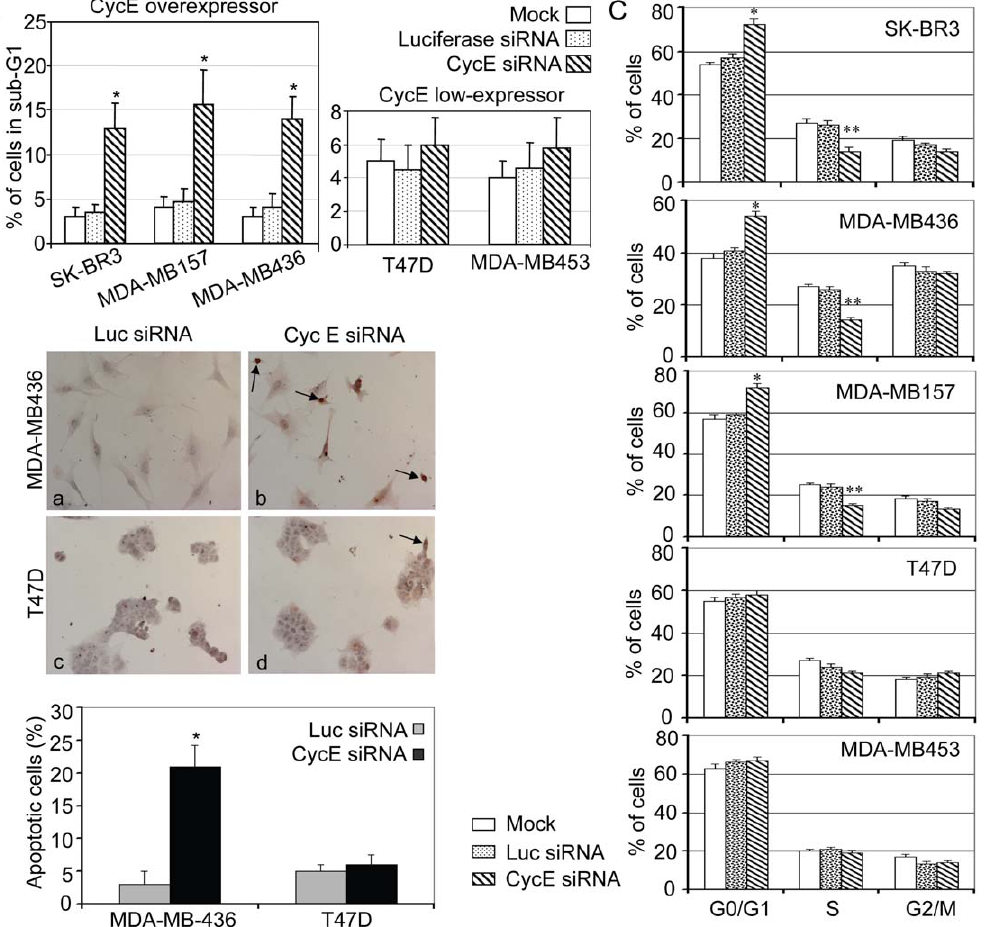
Figure 2. Apoptosis and decreased cell proliferation induced by depletion of cycE in cycE-overexpressing breast cancer cells. A) Downregulation of cycE promotes apoptosis of SK-BR3, MDA-MB436 and MDA-MB157, but not T47D and MDA-MB453. Ninety-six hours after siRNA transfection, the indicated adherent cells were collected by trypsinization and combined with cells floating in the medium. The apoptotic cells were then determined with flow cytometry. (*) p # 0.05 compared with mock. B) Apoptosis in cycE-overexpressing cells are confirmed by TUNEL assay. Two days after siRNA transfection, the indicated cells were subjected to TUNEL analysis. Upper panel: apoptotic cells (purple staining) were detected in MDA-MB436, but not in T47D cells. Lower panel: Percentage of apoptotic cells in the above two breast cancer cells treated with cycE or control siRNA. C) S phase population is decreased by cycE siRNA in cycE-overexpressing cells. Treated cells were collected 48 h after transfection of cycE siRNA in three cycE-overexpressing cells (SK-BR3, MDA-MB436 and MDA-MB157) and two cycE-low expressors (T47D and MDA-MB453). The cell cycle pattern (G0/G1, S and G2/M) was also determined by flow cytometry. Three individual experiments were performed. (*) p # 0.05 compared with mock in G0/ G1 population, (**) p # 0.05 compared with mock in S